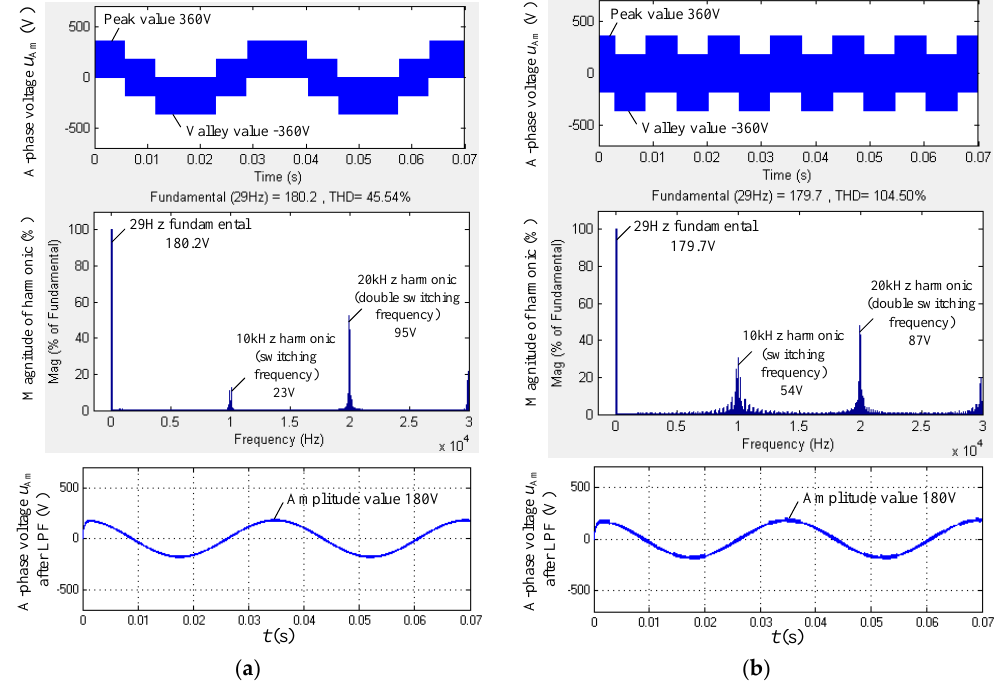
Figure 5. Stator A-phase voltage simulation waveforms, their FFT analysis, and their waveforms after low-pass filtering (LPF) in two methods. ( a ) Conventional SVPWM; ( b ) CMRSVPWM.